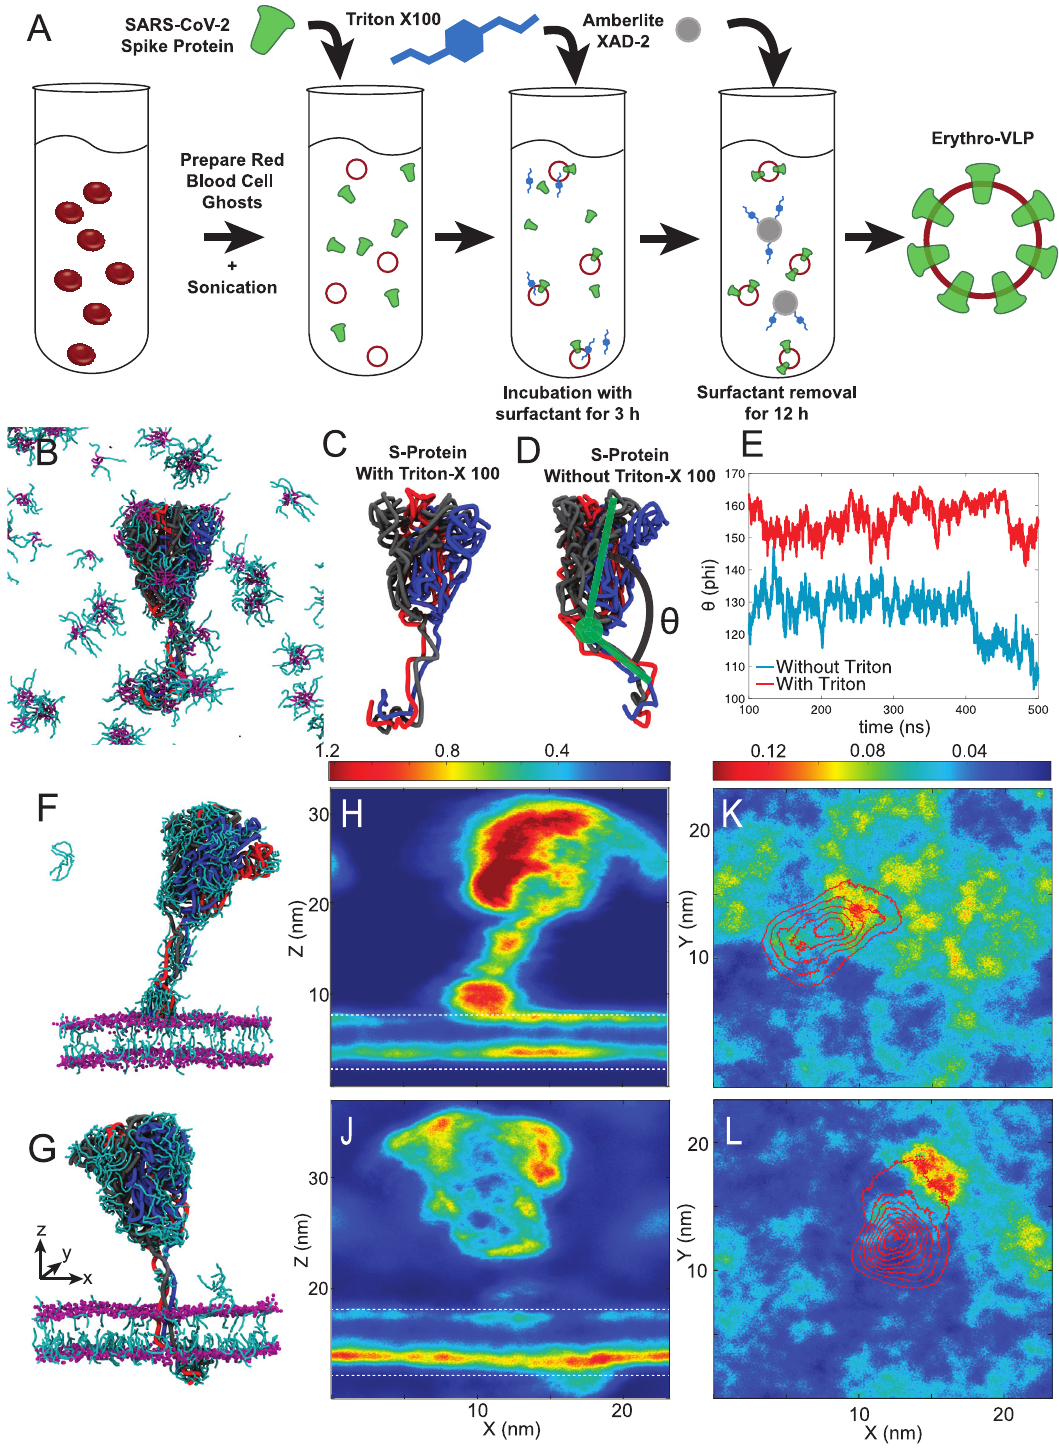
Fig 1. A : Preparation protocol for Erythro-VLPs: Erythrocyte liposomes were prepared from human RBCs. 14 mg/ml erythrocyte liposomes were incubated in a 3 μ M and 25 mM Triton-X100 solution. The detergent was removed by Amberlite XAD-2 and size- exclusion chromatography (SEC). B : Snapshot of a MD simulation of the S-protein in a 25 mM aqueous Triton-X 100 solution after 500 ns. The three chains of the protein are visualized as black, red and blue tubes; Triton-X 100 is represented by cyan rods (hydrophilic head group) and purple rods (hydrocarbon tails). C and D : Snapshots of the S-protein in aqueous solution after 500 ns